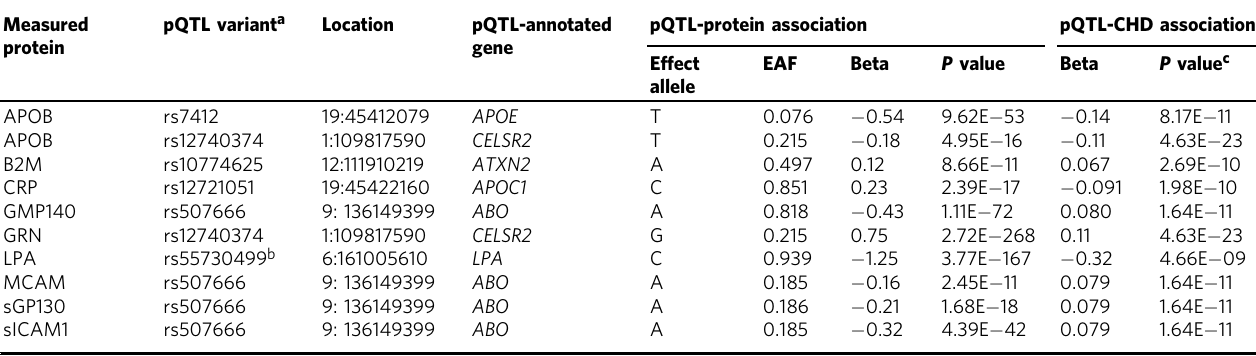
EAF effect allele frequency, CHD coronary heart disease, pQTL protein quantitative trait locus a For proteins with multiple pQTL variants that coincide with coronary heart disease GWAS SNPs, the pQTL variant with the lowest P value of association with its corresponding protein level is shown b Indicates cis -pQTL. All other pQTLs shown in this table are trans -pQTLs c P value of associations with coronary heart disease risk in GWAS reported in the CARDIOGRAMplusC4D